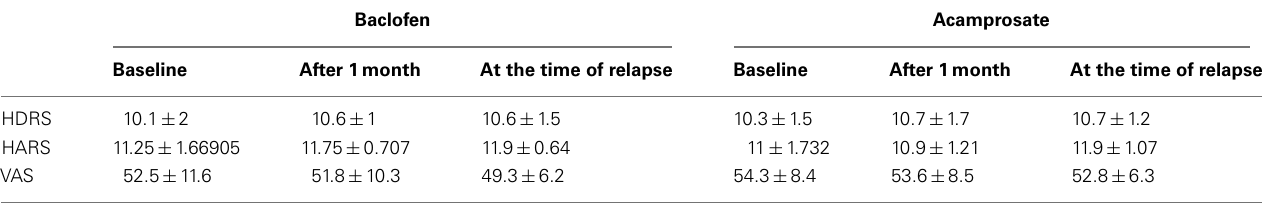
Table 3 | Average scores and SD of HDRS, HARS,